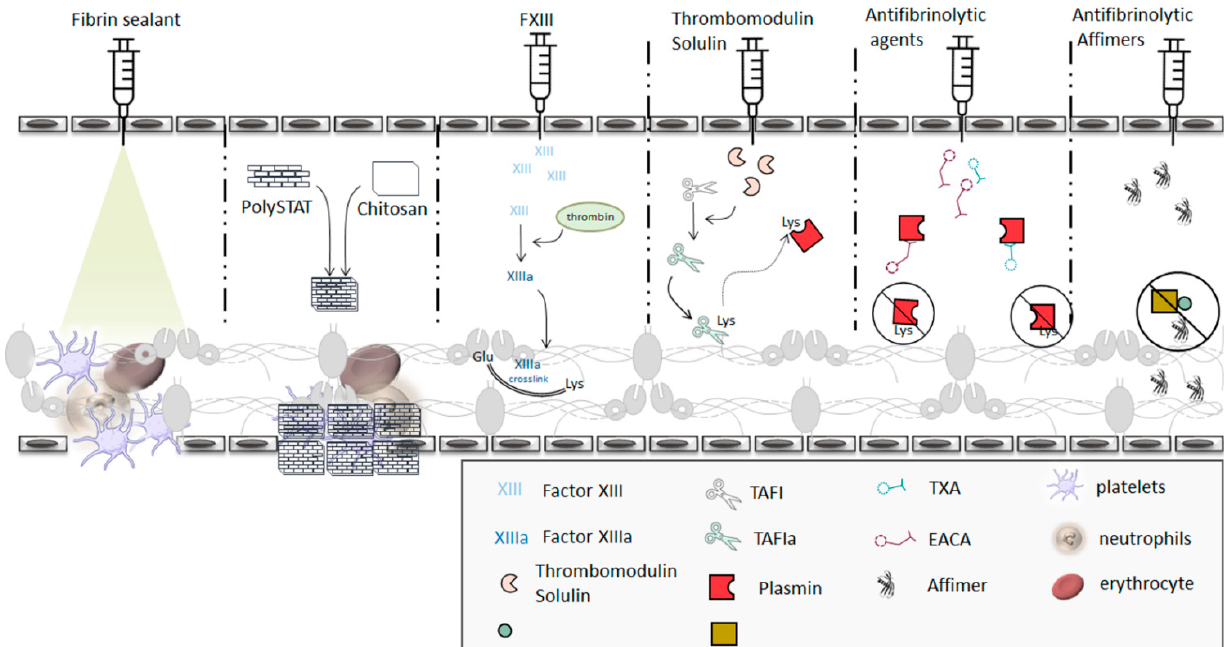
Figure 5. Current hyperfibrinolysis therapeutics and potential alternatives. Fibrin sealants are surgical haemostatic agents composed of a mix of pro-coagulation proteins, which ensure clot formation and prevents premature clot lysis. PolySTAT, a fibrin specific polymer with multiple fibrin domains, facilitates fibrin crosslinking while Chitosan, a biodegradable N-acetylglucosamine polymer, interacts with erythrocytes leading to erythrocyte agglutination. PolySTAT–Chitosan gauzes increase clot stability decreasing susceptibility to lysis. FXIII treatment results in fibrin crosslinking and crosslinking of PI to the fibrin network which improve clot stability and resistance to lysis. Solulin, a soluble form of thrombomodulin, acts by activating TAFI, which in turn cleaves lysine residues on fibrin preventing degradation of fibrin. Synthetic lysine analogues, TXA and EACA interact with plasmin(ogen) and block fibrin–plasmin(ogen) interactions, leading to increased resistance to clot lysis. More recently, Affimers, antibody mimetics raised against fibrinogen, were shown to interact with the fibrin, blocking plasmin-mediated degradation of the fibrin network. In vitro studies showed the potential use of Affimers in stabilizing the fibrin network and preventing premature lysis of the